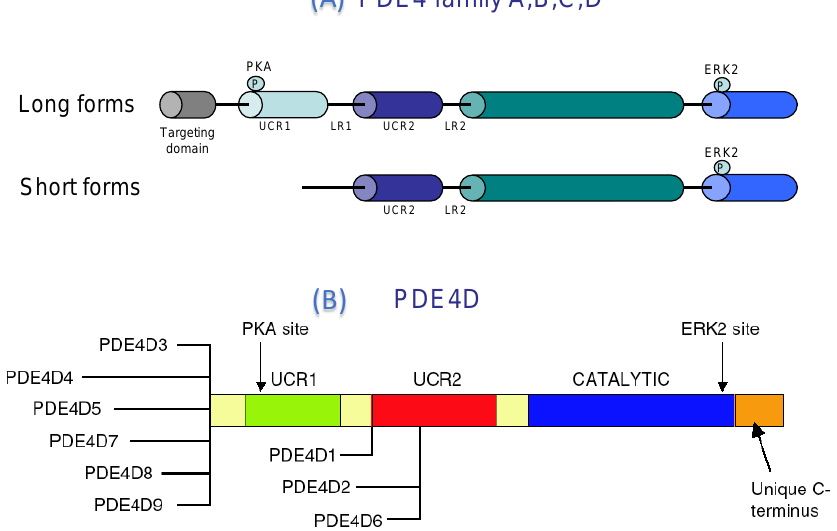
Figure 3. Structure of the PDE4 family. ( A ) Long forms of PDE4 contain both UCR1 and UCR2 and could be phosphorylated by PKA increasing PDE4 activity, whereas short forms lacking UCR1 could not be regulated by PKA and only exist as monomer [1]. ( B ) Diversity of PDE4D variants, Reprinted/adapted with permission from Ref. [24].